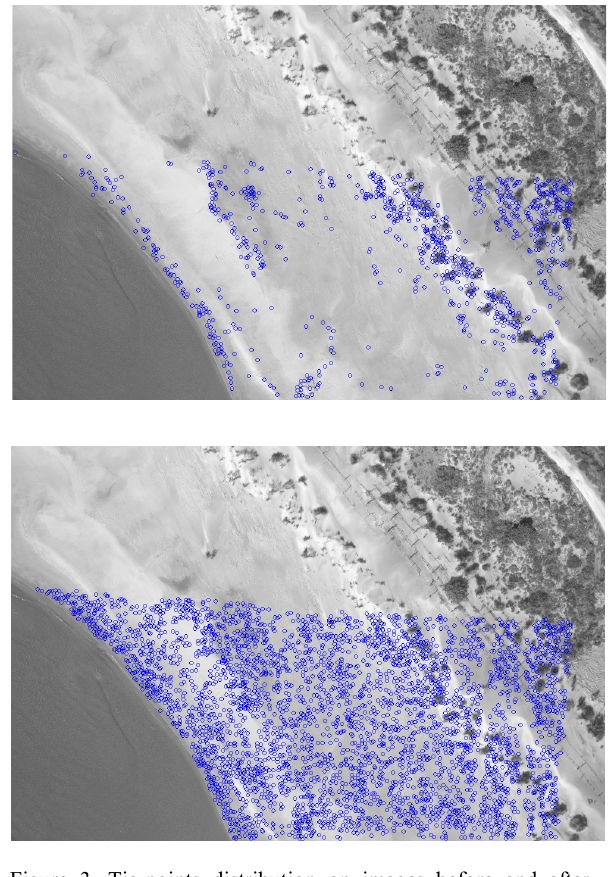
Figure 3. Tie-points distribution on images before and after